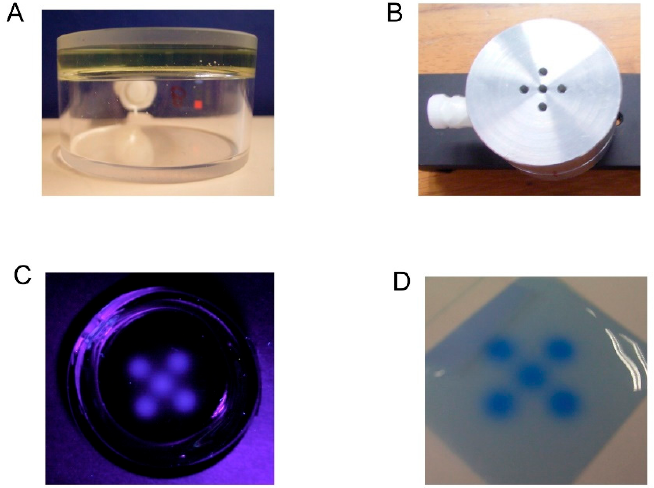
Figure 3. The first test measurement of fixed fluorescence imaging using the RFG gel production procedure described in the text. ( A ) A cylindrical spectrosil cell containing a (slightly yellow) 5 mm layer of a quasi-rigid gel containing ~1 mM MPy in TBA/15%PTBA. ( B ) The 5 mm thick aluminum mask for collimating the 3 MeV electron beam. ( C ) The fluorescent image of the gel in 365 nm light after irradiation with a dose of 20 Gy. ( D ) Comparison with a radio-chromic film irradiated under the mask to 10 Gy.